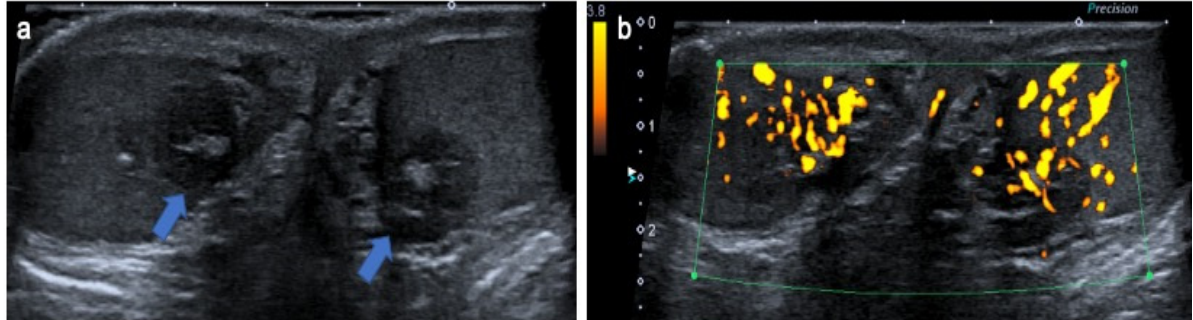
Figure 10 . Testicular adrenal rest tumors in a 6-month boy with congenital adrenal hyperplasia. Transverse gray-scale B-mode ( a ) and color Doppler ( b ) US of the testis. Images show bilateral and symmetric lesions at the hilum of the testis, mostly hypoechoic with a hyperechoic center, lobulated margins (blue arrow) and increased intralesional flow preserving the normal vascular architecture.